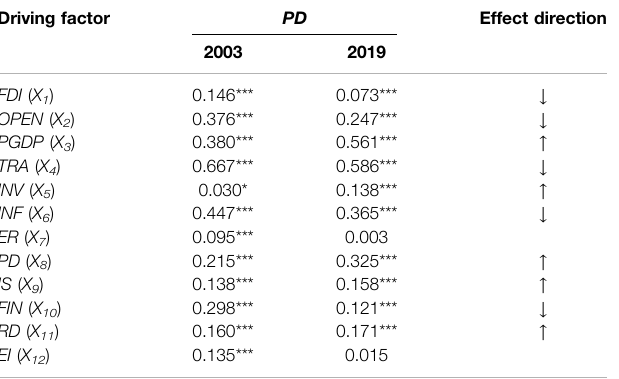
TABLE 3 | Power of the determinant value ( PD value) for driving factors in China (2003 and 2019). Driving factor